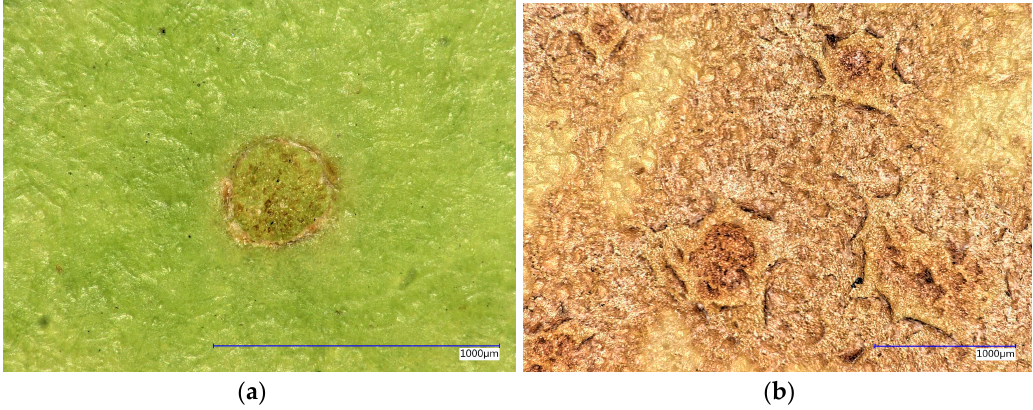
Figure 3. Color 3D micrographs of smooth-skinned, russet-devoid ( a , left) and russet ( b , right) pears at 200-fold magnification—the blue distance bar represents 1 mm.